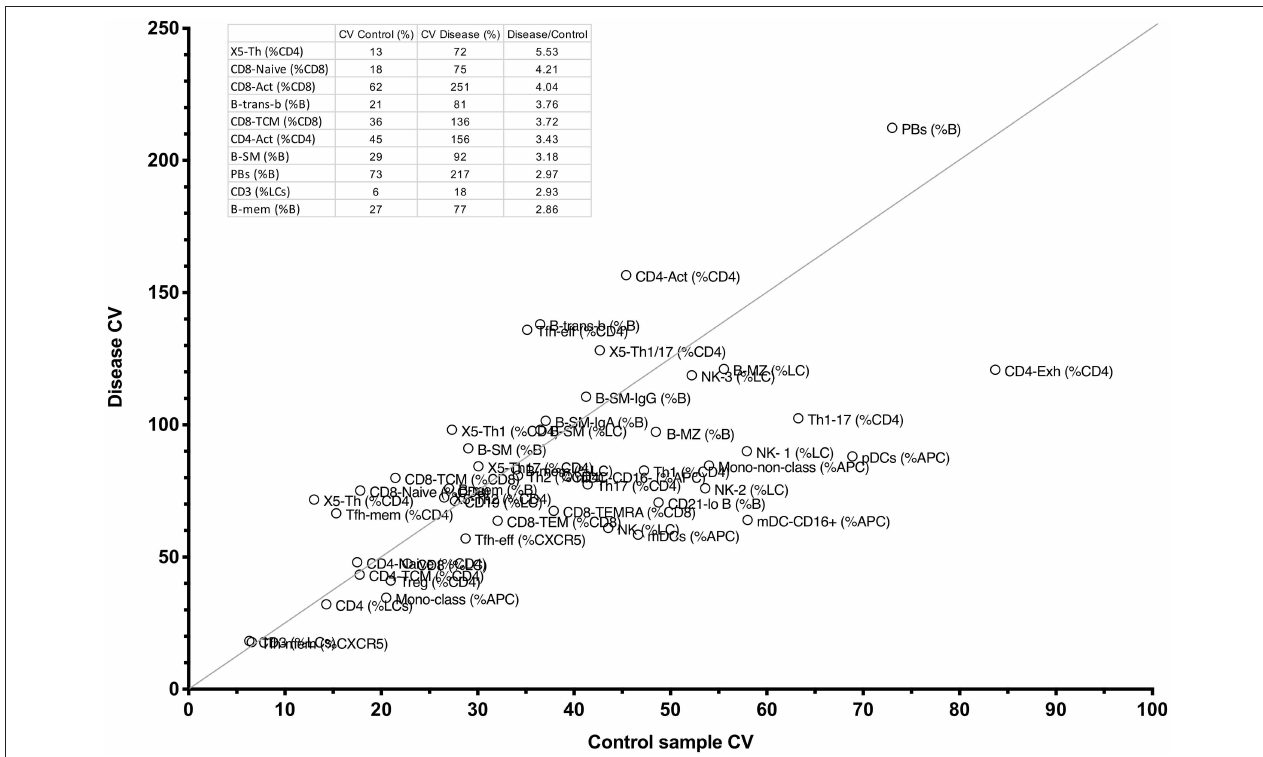
FIGURE 7 | Comparison between CV percentages of 51 cellular parameters derived from the internal FCM control, and the same variation in the entire CPI cohort with widely varying immune conditions (see section Methods). The line shows the cut-off for the top 10 parameters with the highest ratio of disease-driven variation divided by internal variation, and these 10 parameters, and corresponding raw values appear in the table